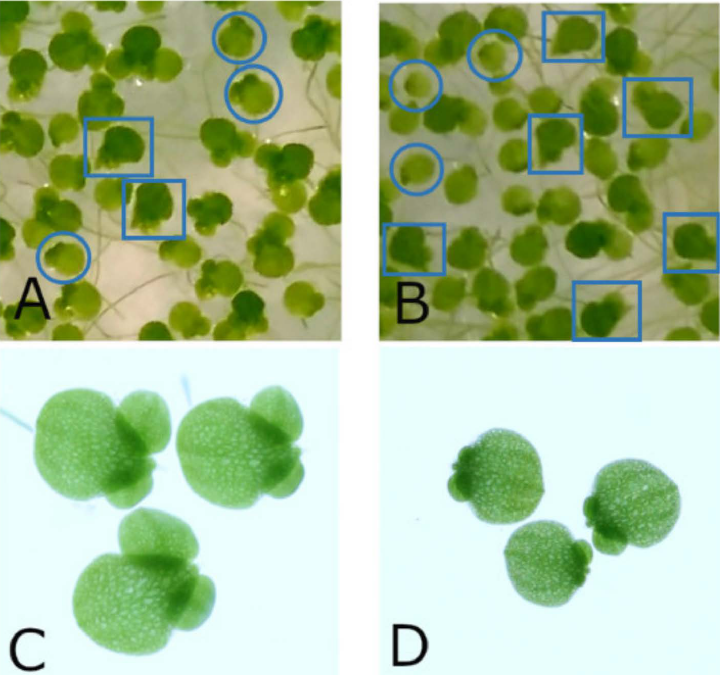
Figure 3. Morphological changes induced by different concentrations of AsNa 2 HO 4 on Lemna gibba L. by 48 h incubation resulted in the separation of mother and daughter fronds (leaf-like structure). ( A ) 158 mg/L AsNa 2 HO 4 plants prior to sorting ( B ) 250 mg/L AsNa 2 HO 4 plants prior to sorting ( C ) 158 mg/L AsNa 2 HO 4 sorted and ( D ) 250 mg/L AsNa 2 HO 4 sorted. ( C , D ) have the same scale. Blue circles indicate plants considered optimal for experiments. Diameter of fronds and daughter fronds are smaller after stress with 250 mg/L AsNa 2 HO 4 (see A ) compared to 158 mg/L AsNa 2 HO 4 (see B ). Blue rectangles indicate severely stressed plants, recognisable by their droplet-like morphology. Their number increases with a higher arsenic stress. More severely stressed plants have a tendency to develop chlorosis (whitening due to loss of